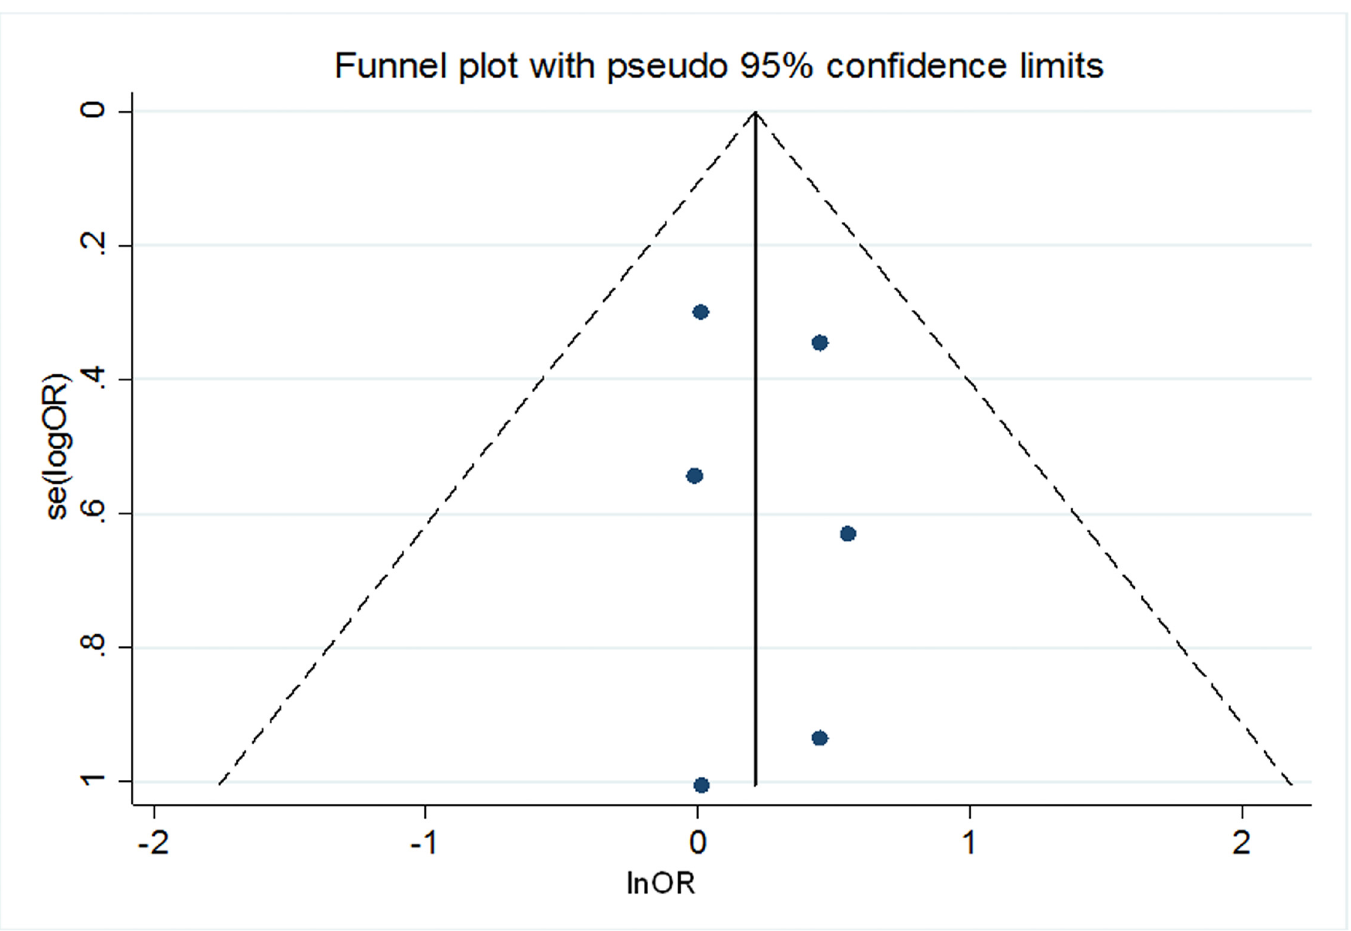
Fig 4. Estimation of publication bias. A funnel plot of SE versus ln(OR) for the meta-analysis. When the standard error is used on the y axis of a funnel plot, it is conventional to reverse the axis so that the most precise studies are displayed at the top of the plot. They tend to cluster near the mean effect size. Smaller studies are depicted at the bottom of the graph and tend to be dispersed in a range of value. In absence of publication bias as shown in the present figure the studies are distributed symmetrically about the combined effect size. The pseudo 95% confidence limits illustrate the expected 95% confidence interval about the pooled fixed-effects estimate for the